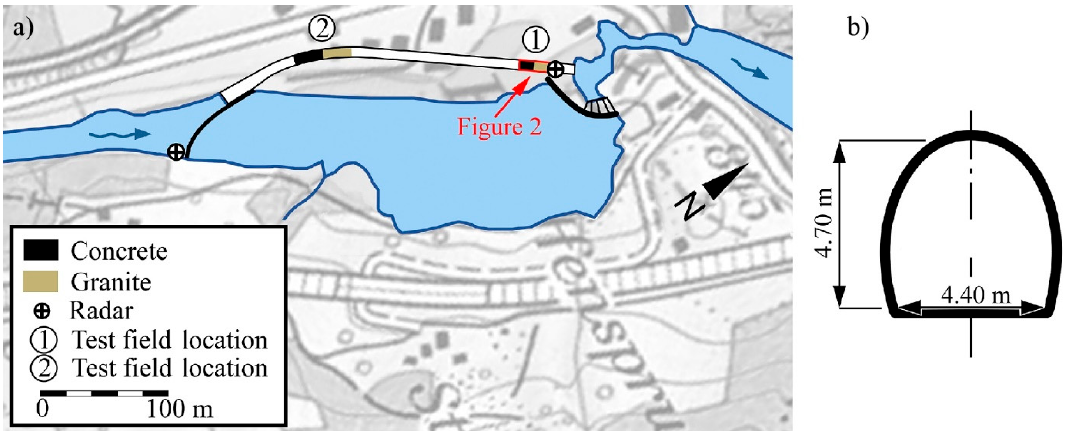
Figure 1. ( a ) Overview and ( b ) cross section of the Pfaffensprung SBT (position 46°42’49.8” N 8°36’36.7” E) with test field locations 1 and 2 and radar instrumentation for discharge monitoring, position of Figure 2 highlighted red.